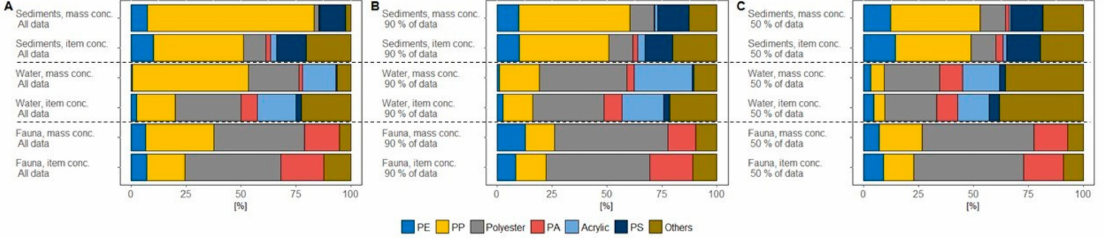
Figure 3. Polymeric composition of sediments, water and fauna. ( A ) All data. ( B ) The 5% least